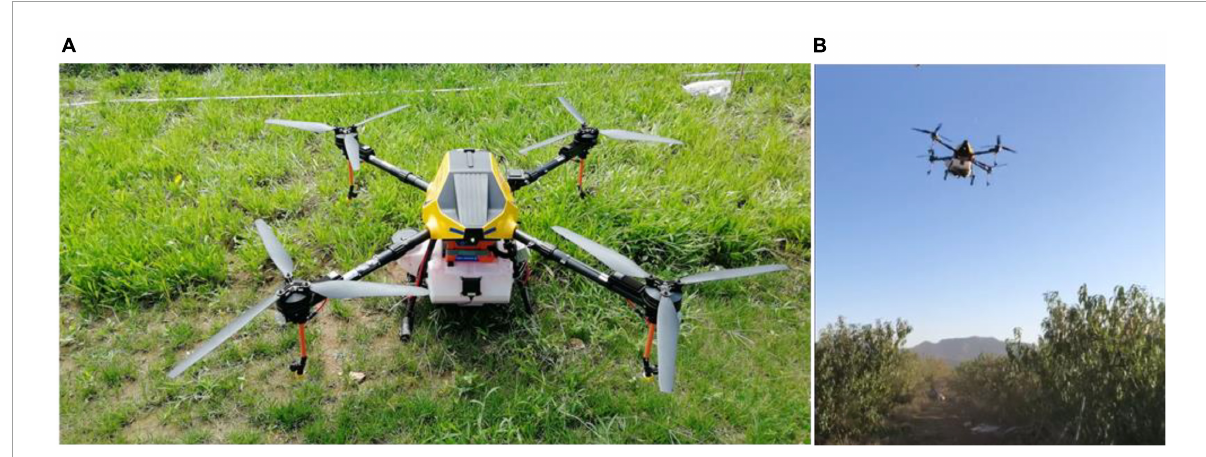
FIGURE1 Experimental site. (A) 3WYD-4-22A plant protection UAV; (B) spraying in peach